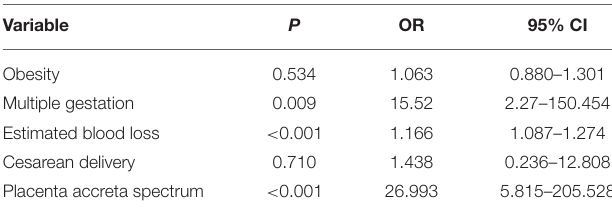
TABLE 4 | Multivariate regression analysis for the outcome of intrauterine balloon tamponade failure.